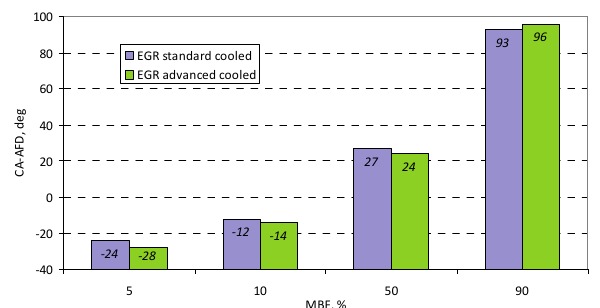
Fig. 27. Impact of EGR cooling system at CA –AFD of MBF specific value (engine rotational speed: 1800 rpm, load: 190 Nm load)